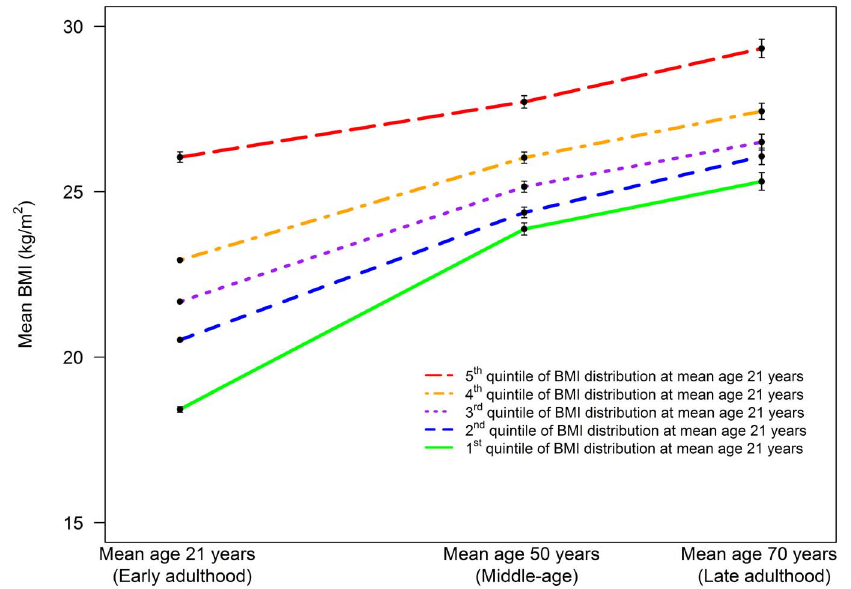
Figure 1. Distribution of BMI at mean age 21 years (early adulthood), 50 years (middle-age), and 70 years (late adulthood).